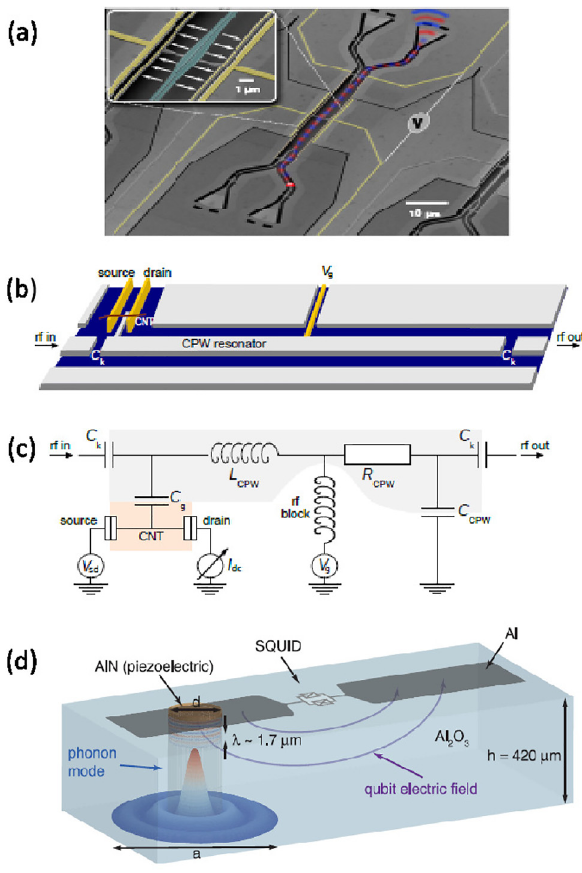
Figure 3: Applications to photon, charge, and phonon manipulation. (a) False-color scanning electron micrograph of the single-photon router. The red spot marks the approximate position of the quantum dot used for the experiment. The inset shows a zoom-in of the central section of the device where the waveguides have been highlighted in blue [30]. (b) Schematic drawing of the optomechani- cal device about charge control, and (c) corresponding circuit. The carbon nanotube, marked in brown in the model [35]. (d) Schematic of piezoelectric coupling to the modes of a high-overtone bulk acoustic wave resonator. The sine curve in the figure represents the longitudinal part of the wave function, and it has a wavelength 𝜆 = 2 h ∕ l on the cylindrical mode volume defined by the AlN disc and the sapphire substrate below. The transverse energy density profile of s ( ⃗ x ) is plotted in 3D, showing the effective confinement of l , 0 energy inside the mode volume